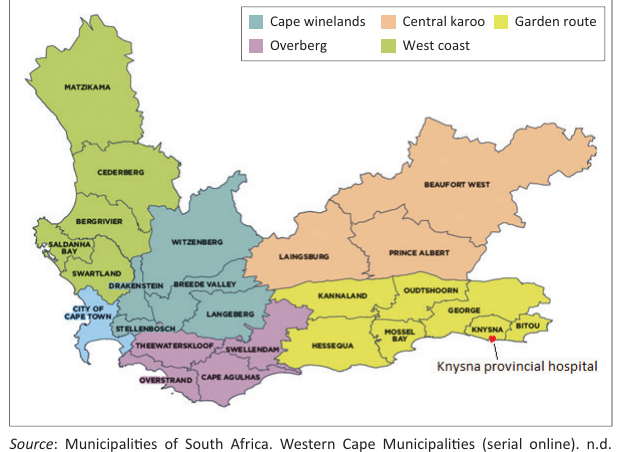
FIGURE 1: A regional representation of the Western Cape demonstrating the location of the Knysna and Bitou sub-districts in relation to George sub-district, the rest of the Garden Route district and Cape